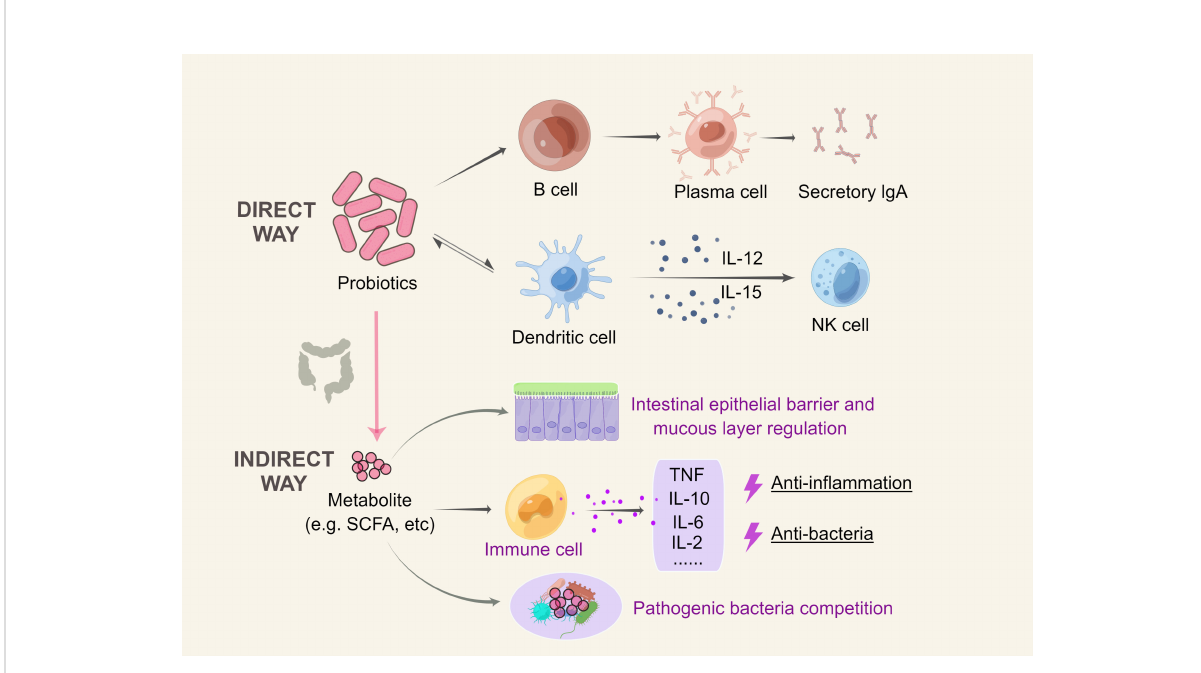
FIGURE 2 Mechanism of action of probiotics. Direct mechanism: probiotics can activate sentinel cells through the Toll-like activation of signaling pathways; DCs can drive NK cell activation by secreting cytokines such as IL-12 and IL-15, and probiotics can impact this pathway; probiotics can cause B cells to differentiate into IgA-producing plasma cells; and probiotics also interact with antigen-presenting cells to in fl uence the reduction of proin fl ammatory cytokines, thereby triggering an adaptive response. Indirect mechanism: Through the manipulation of the gut epithelial barrier and mucus layer properties, probiotic release of antimicrobial compounds, and management of competition with pathogenic bacteria, speci fi c probiotic metabolites may exert anti-in fl ammatory and antibacterial effects. This fi gure was drawn by